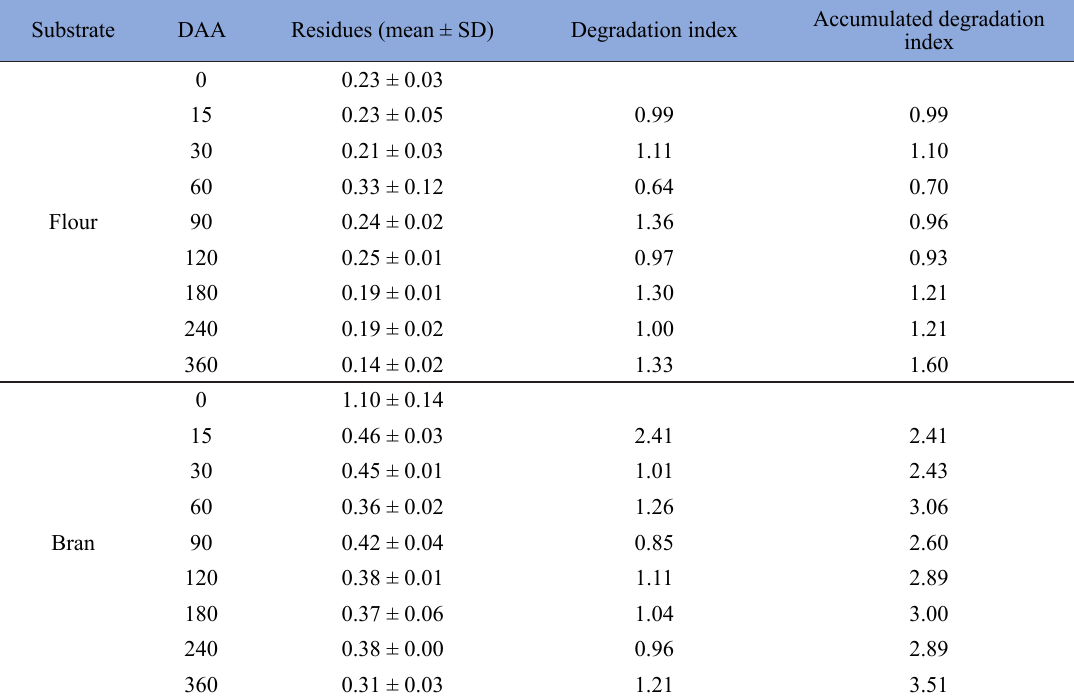
DAA: Days after application. Table 5. Esfenvalerate residues (mg kg−1) in wheat flour and bran.